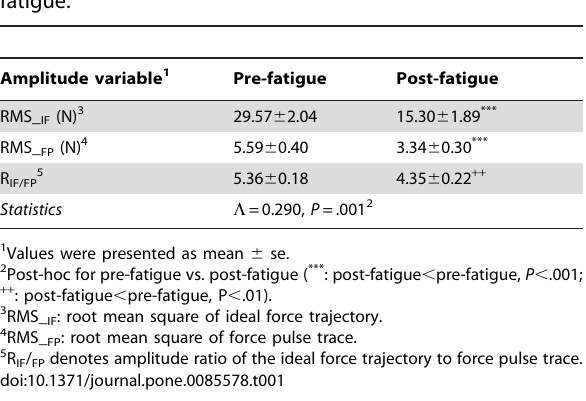
Table 1. The contrast of amplitude variables of the ideal force trajectory and force pulse between pre-fatigue and post-